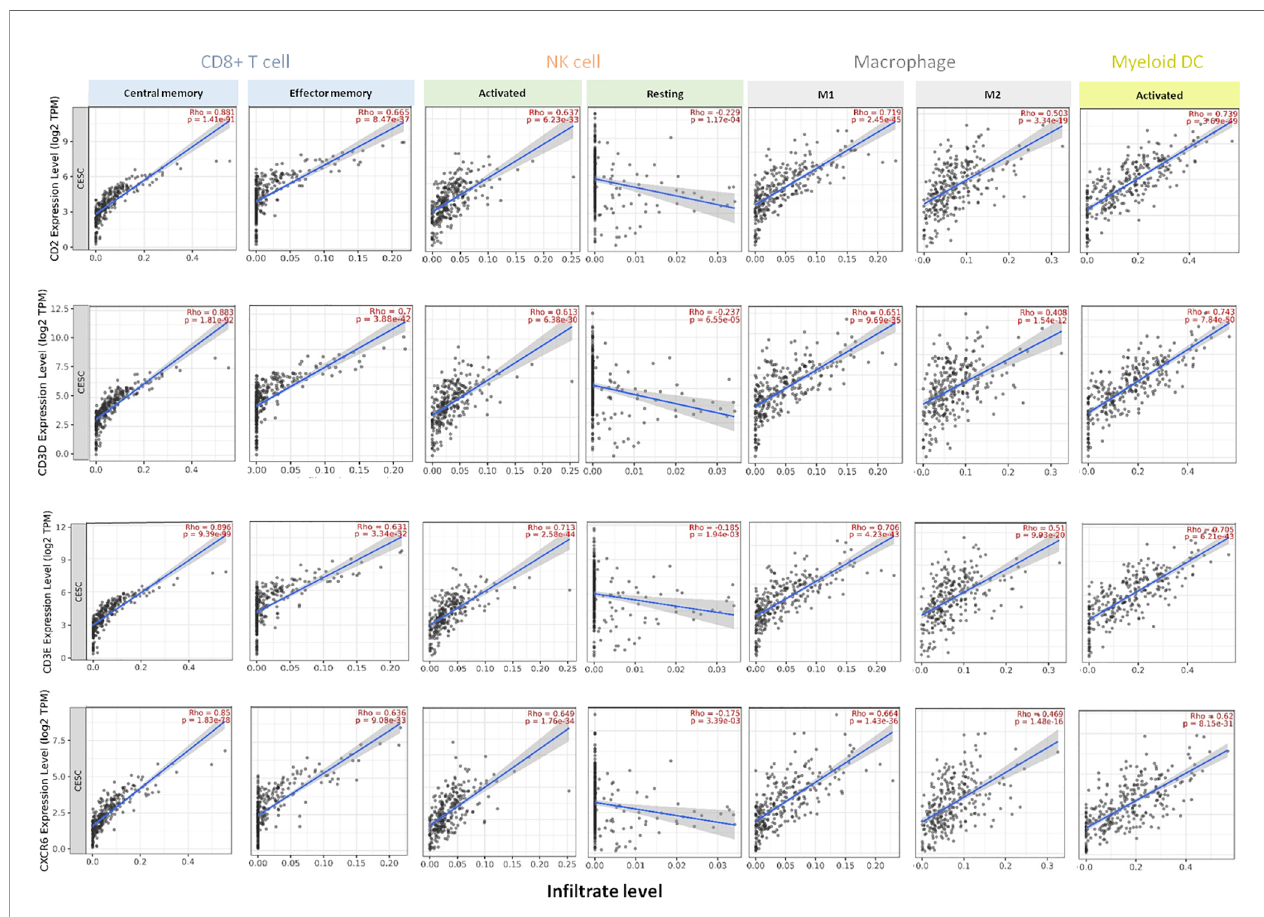
FIGURE 6 | Association of CD2 , CD3D , CD3E , CXCR6 transcriptomic expression with speci fi c tumor-in fi ltrating immune cell populations in CSCC patients. Expression of each gene in association with the presence of CD8+ T cells (central memory and effector memory subsets), NK cells (activated or resting), macrophages (M1 and M2 types), and activated myeloid dendritic in fi ltrates in CSSC patients (n = 254). Each panel presents the relationship between in fi ltrates estimation value with the purity-adjusted spearman ’ s correlation parameter Rho and gene expression, join p value < 0.001. Rho value > 0 represents a positive correlation, and Rho < 0 represents a negative correlation. Association with immune cell populations was provided by TIMER 2.0 software and was correlated with transcriptome expression level of each immune